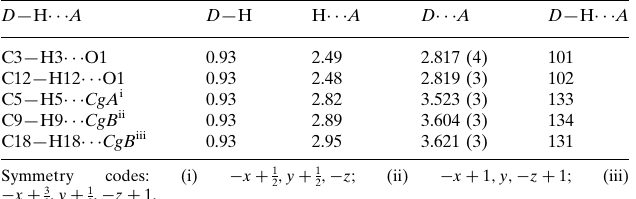
Hydrogen-bond geometry (A˚ , (cid:1) ). CgA and CgB are the centroids of the C4–C9 and C13–C18 rings,